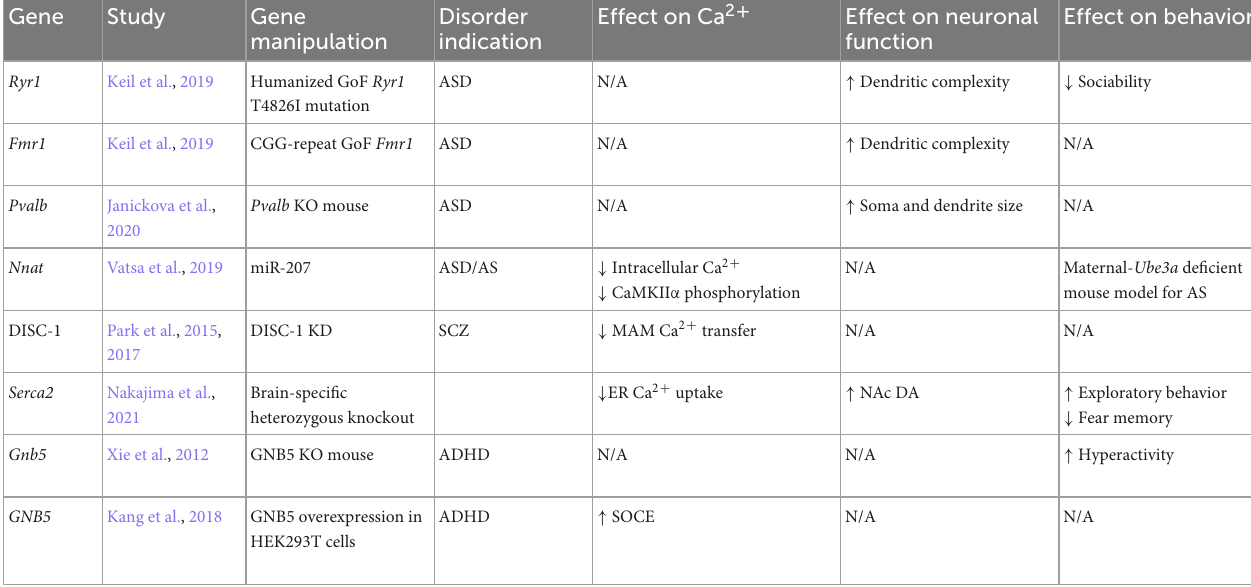
TABLE 1 Studies focusing on notable genes implicated in the pathophysiology of neurodevelopmental disorders and summarized findings on intracellular Ca 2 + signaling, neuronal function, and